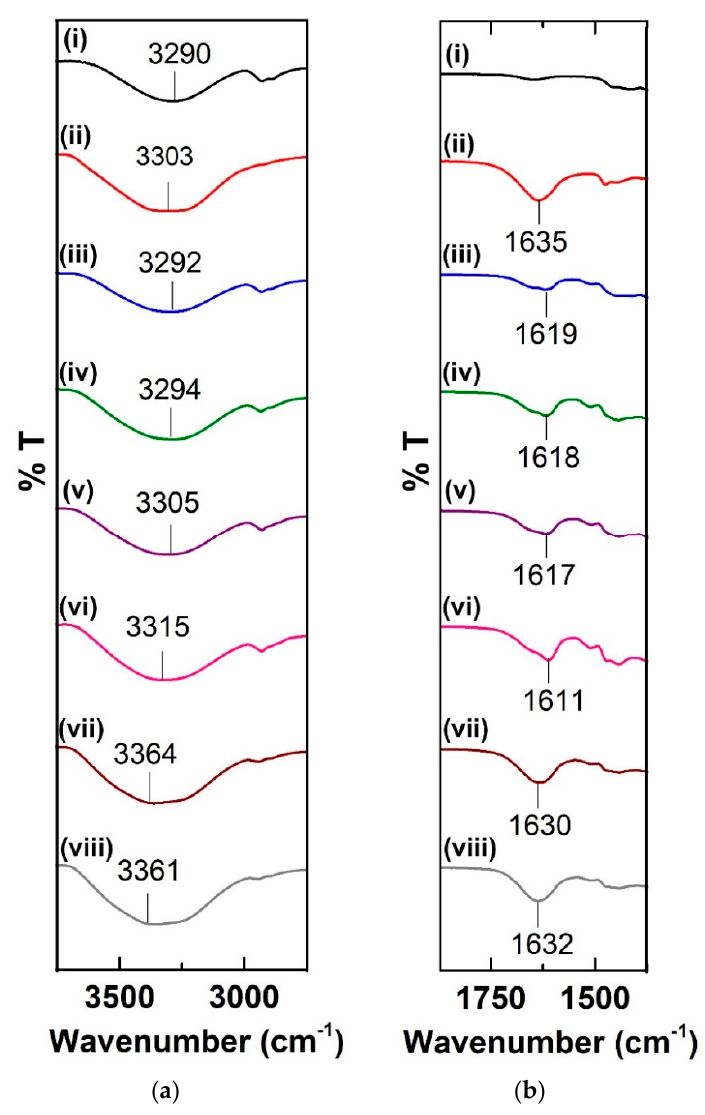
Figure 4. FTIR spectra at ( a ) the hydroxyl region and ( b ) the aromatic region of (i) pure starch film, (ii) RF, (iii) SRF15, (iv) SRF30, (v) SRF45, (vi) SRF60-1, (vii) SRF60-2, and (viii) SRF60-3.